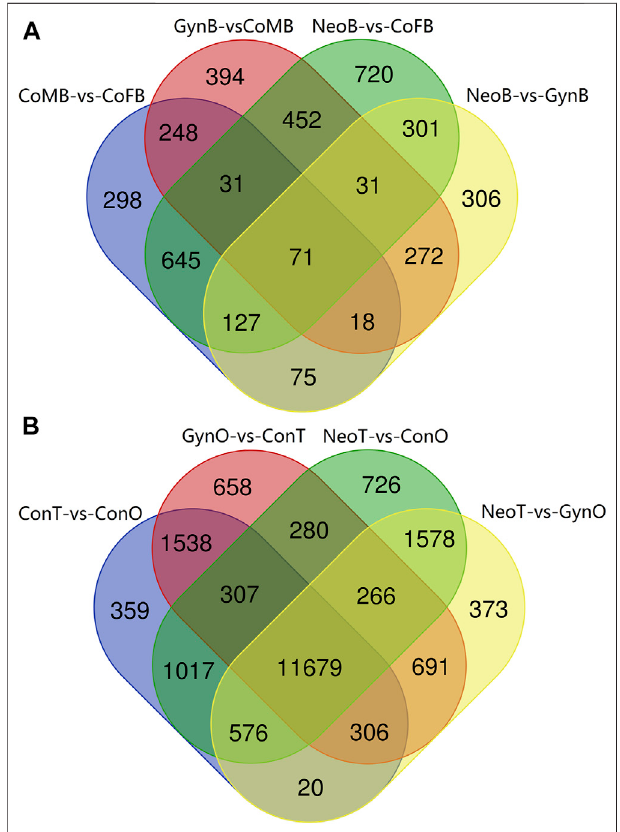
FIGURE 4 | Venn diagram of the male_brain-vs-female_brain (A) and testis-vs-ovary (B) groups.